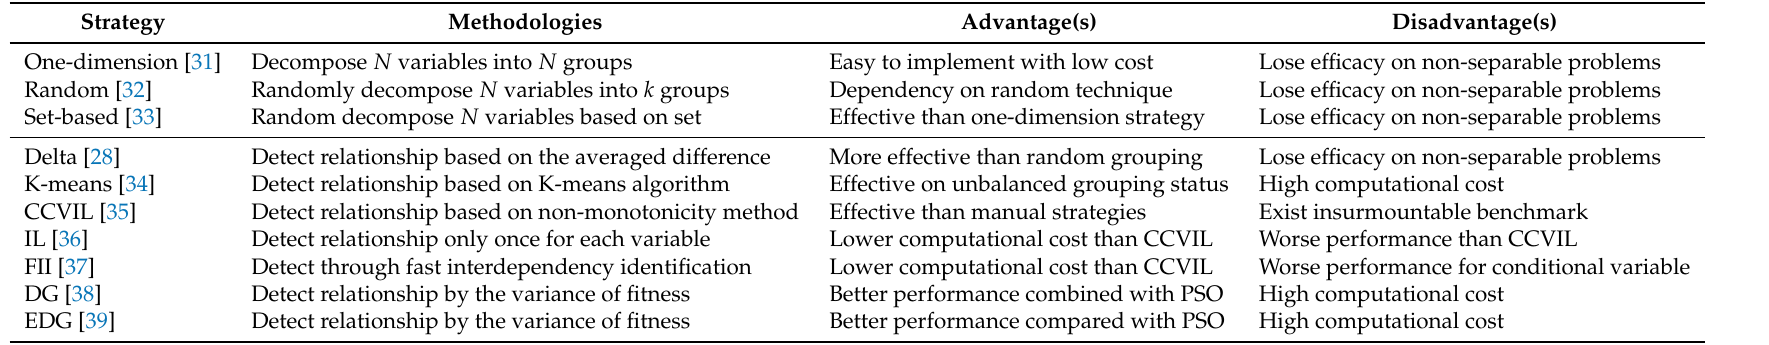
Table 2. A summary of the definition , advantages and disadvantages of the existing decomposition